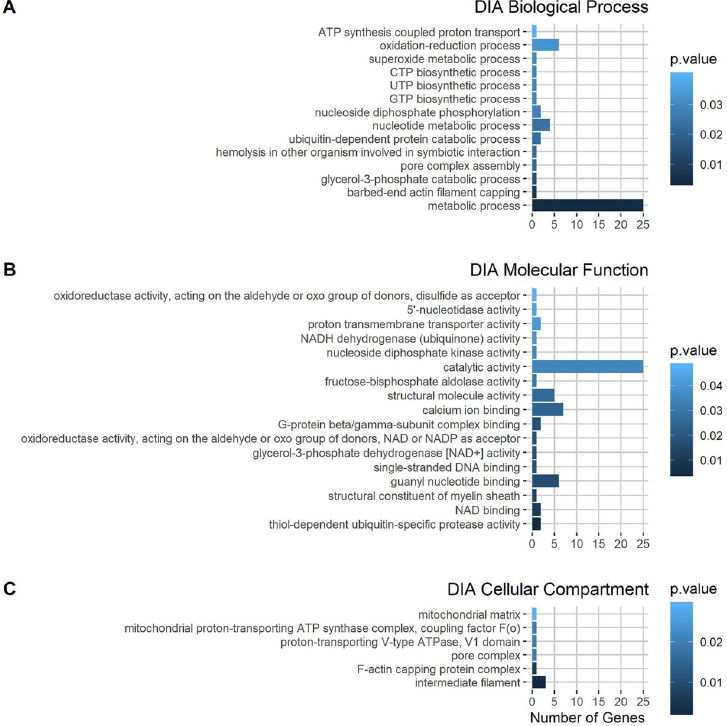
Fig 4. GO term enrichment of upregulated proteins in diapause III (DIA). A) Biological process GO terms, B) molecular function GO terms, and C) cellular compartment GO terms. The color of each bar corresponds to the p- value of the Fisher test (see legend of each plot). The output of the analysis and the genes associated with each GO term are shown in S3 Table.